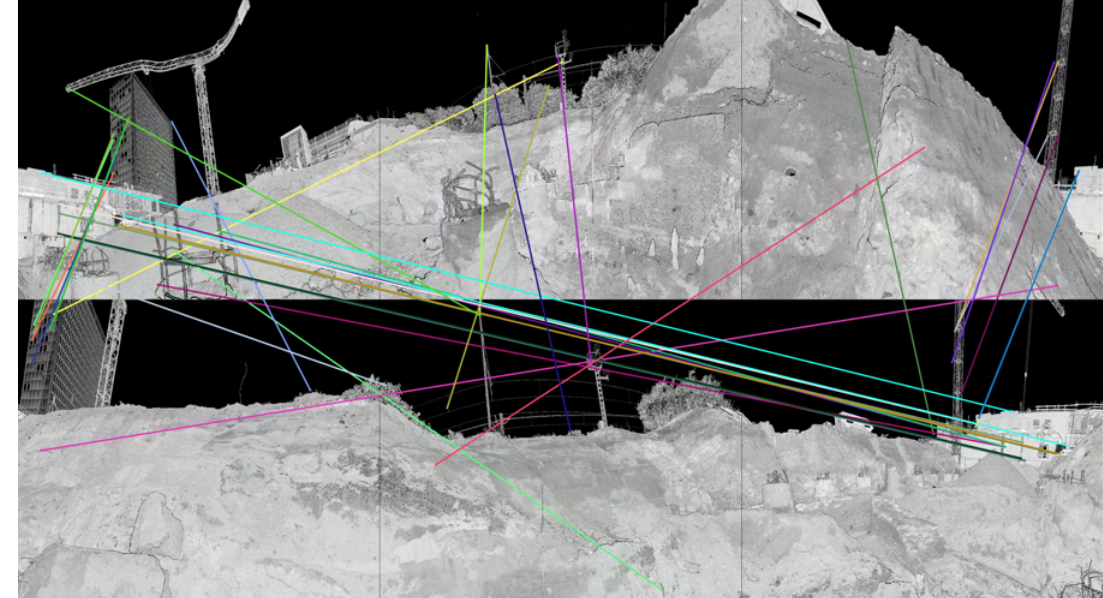
Figure 2: Registration of two 3D scans acquired at an excavation site using SIFT features and SIFT descriptors on a Pannini based projection of the full 360 degree scan. For the Pannini projection, the image was divided into three